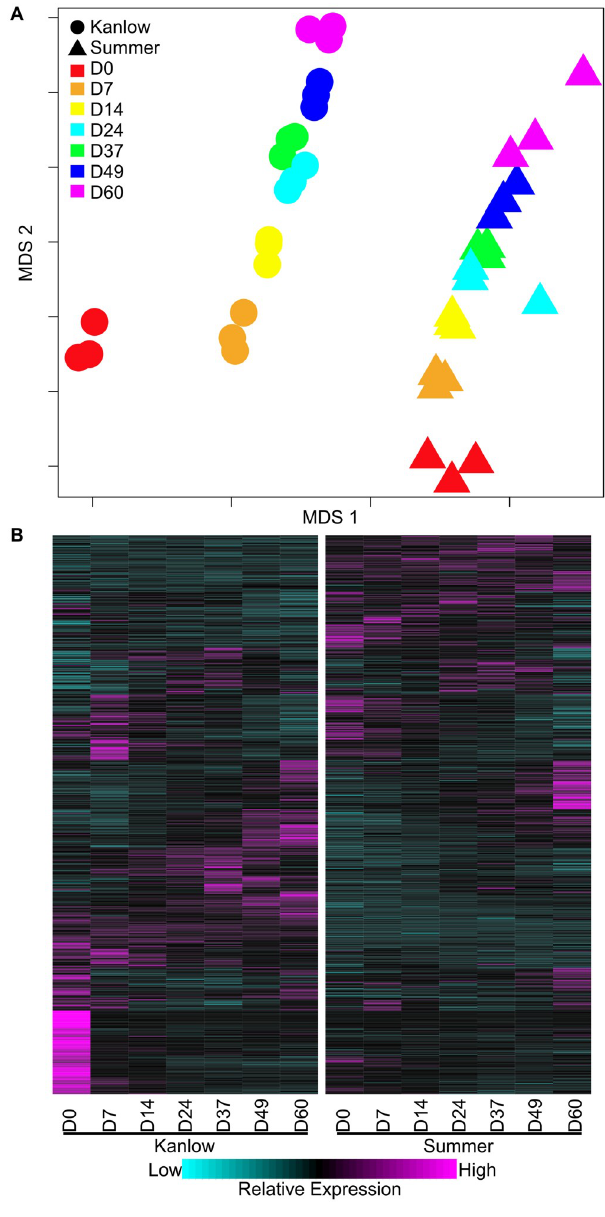
Fig 2. Global leaf transcriptome analysis. (A) MDS analysis and (B) gene expression heatmap. Harvest dates as described for Fig 1. In panel A, Kanlow transcriptomes are in circles and Summer transcriptomes are in triangles. Each harvest date is color coded. In panel B, one way clustering was performed and the dendrograms removed for ease of presentation. Expression profiles are shown as z-scores with magenta = high expression and cyan = low/no expression.